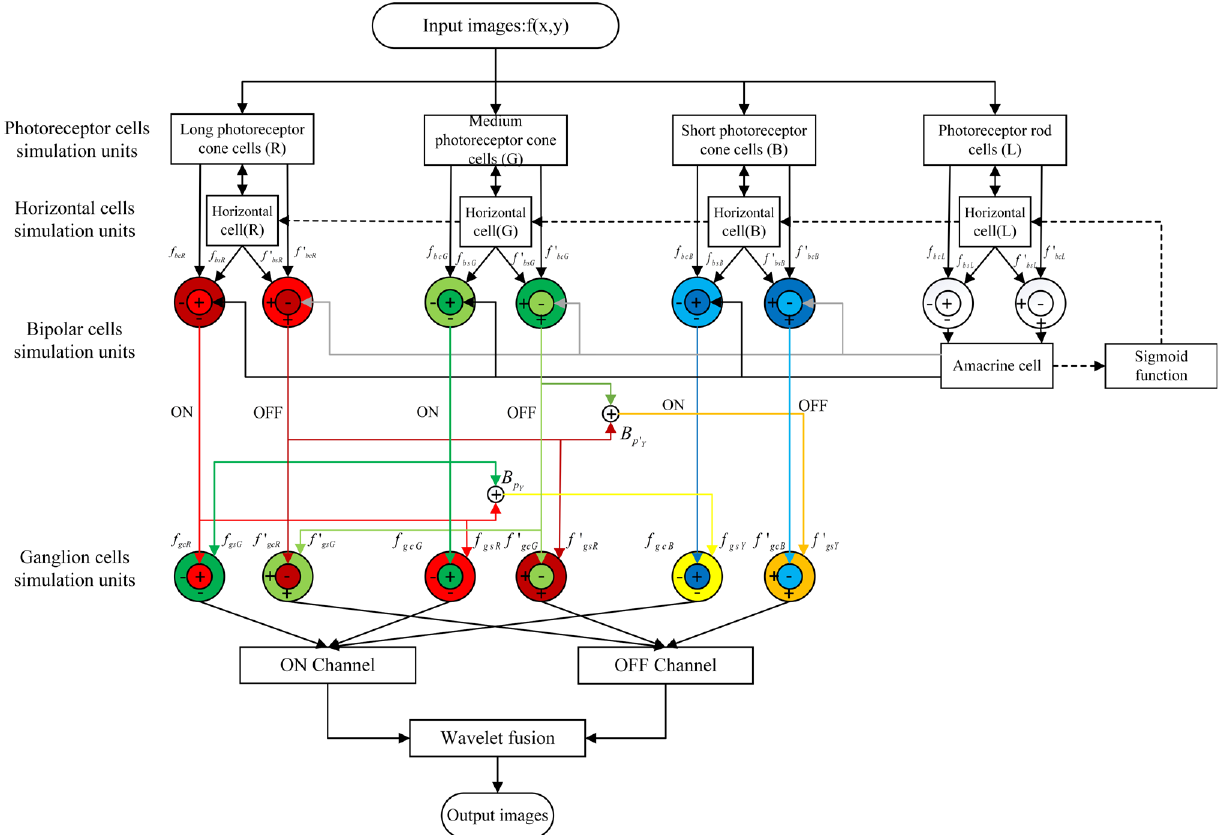
Figure 1. The flow chart of the multi-scale retinex enhancement algorithm. The photoreceptor cells first receive the external light and then generate corresponding nerve signals. The horizontal cells are responsible for receiving the nerve signals of the photoreceptor cells. The receptive field of the bipolar cells is divided into two types: the central area and the outer circle area. Amacrine cells are responsible for normalizing the neural signals from the bipolar cells. Ganglion cells also have a cen- ter-outer receptive field structure in the shape of a concentric circle.